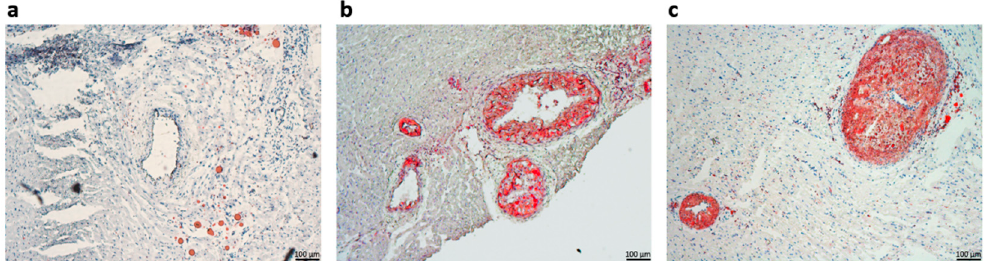
Figure 4. Representative hematoxylin and Oil Red O staining of left-descending coronary artery sections showing nuclei and lipid deposits, respectively, for control-C ( a ), PCSK9 siRNA-treated hyperlipidemic animals-Asi ( b ), and the advanced hyperlipidemic animals-Au ( c ).